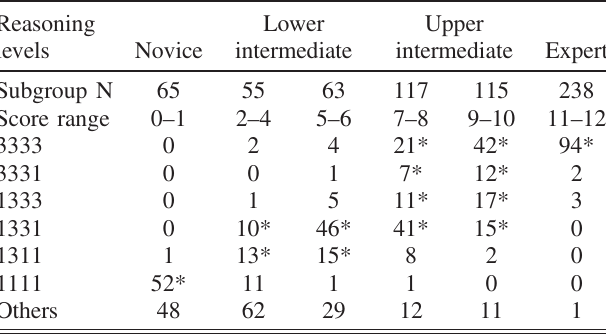
TABLE VII. Distribution of the 4-question response patterns from students at different overall performance levels. The data combines both college and high school datasets ( N ¼ 653 ). Students are grouped in 6 levels based on their total scores on the 12-question test. The second level is set with a wider score range of 3 points to accommodate for the smaller number of students in that range. The numbers are the percentages of individual patterns normalized based on the total possible patterns among all three scenarios within each performance level. Values that are important in identifying the reasoning levels are each marked with an asterisk